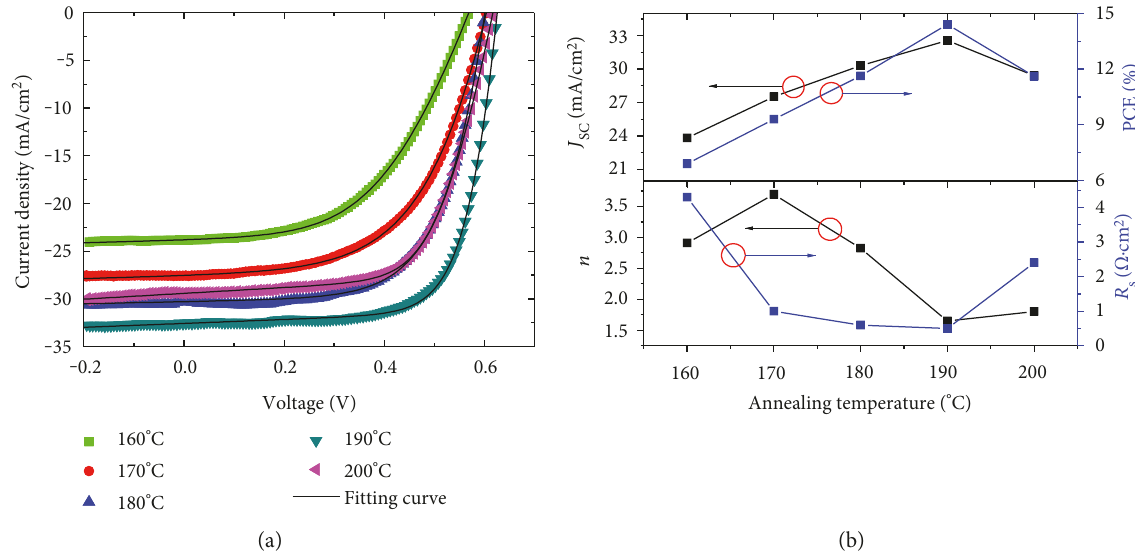
Figure 3: (a) Illuminated J - V characteristics of the solar cells annealing on di ff erent temperatures. The J - V experimental data are fi t by (1). (b) The cells ’ parameters with di ff erent annealing temperatures.